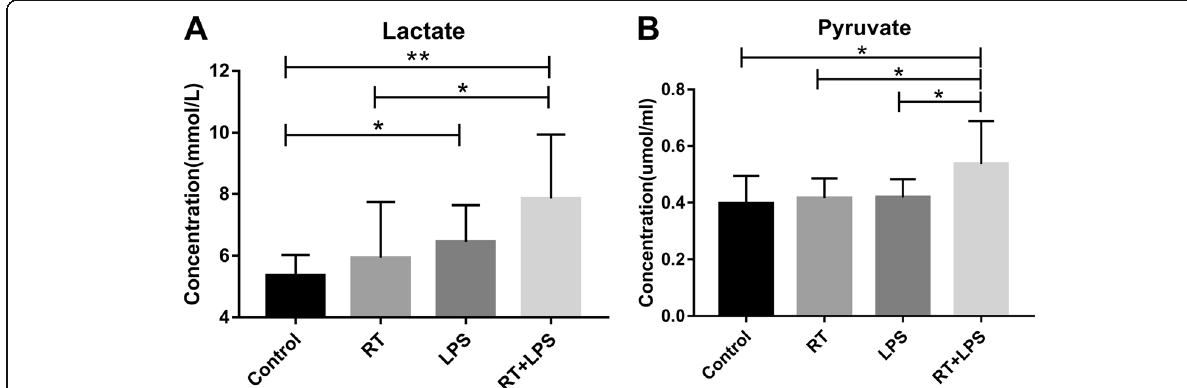
Fig. 6 Plasma concentrations of lactate ( a ) and pyruvate ( b ) in the four treatment groups: control, radiotherapy (RT)-only, lipopolysaccharide (LPS)-only, and RT+LPS groups. * P < 0.05, ** P <